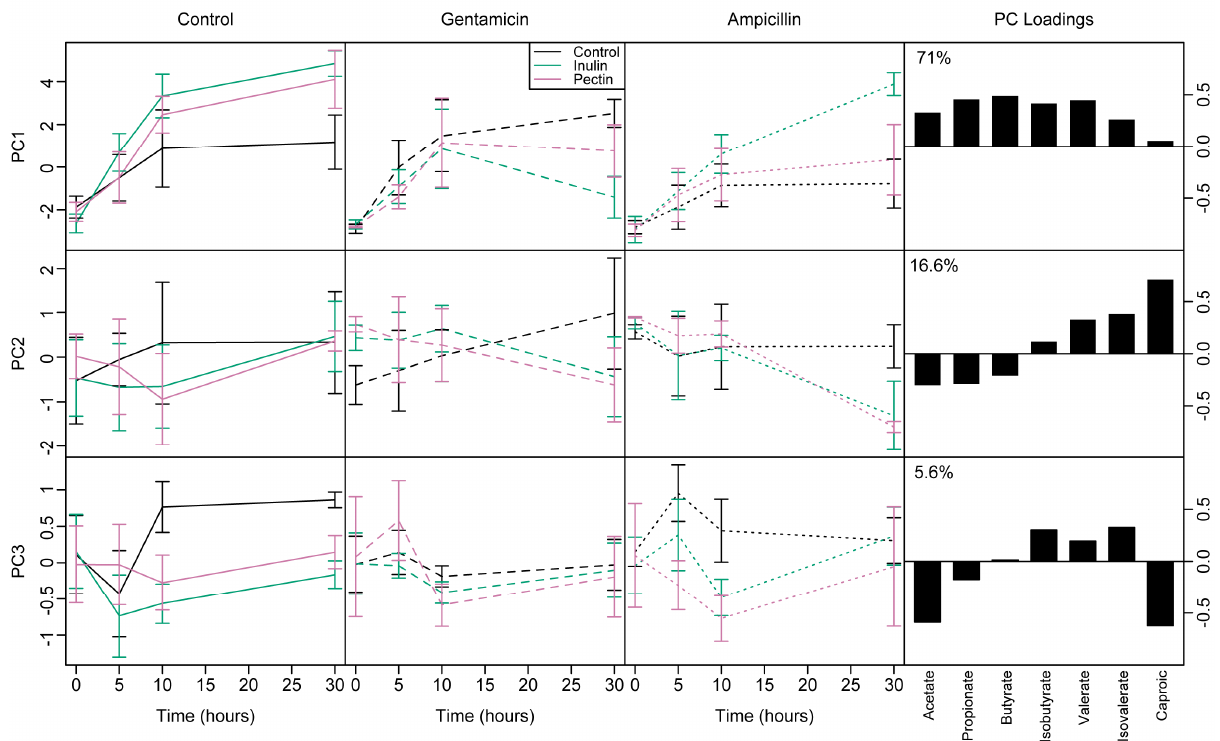
Figure 3. Changes through time of the first three principal components summarising variation in short chain fatty acids (SCFAs) log(concentrations). Black = control; green = inulin; pink = pectin. Solid = control antibiotics; dashed=gentamicin; dotted = ampicillin. The loadings and % variation for each principal component are shown in right-hand panels. Principal component 1 (PC1) represents production of all SCFAs except caproate. Principal component 2 (PC2) represents increasing concentration of SCFAs of longer chain length. Principal component 3 (PC3) represents proportionately increased concentration of BCFAs relative to acetate and